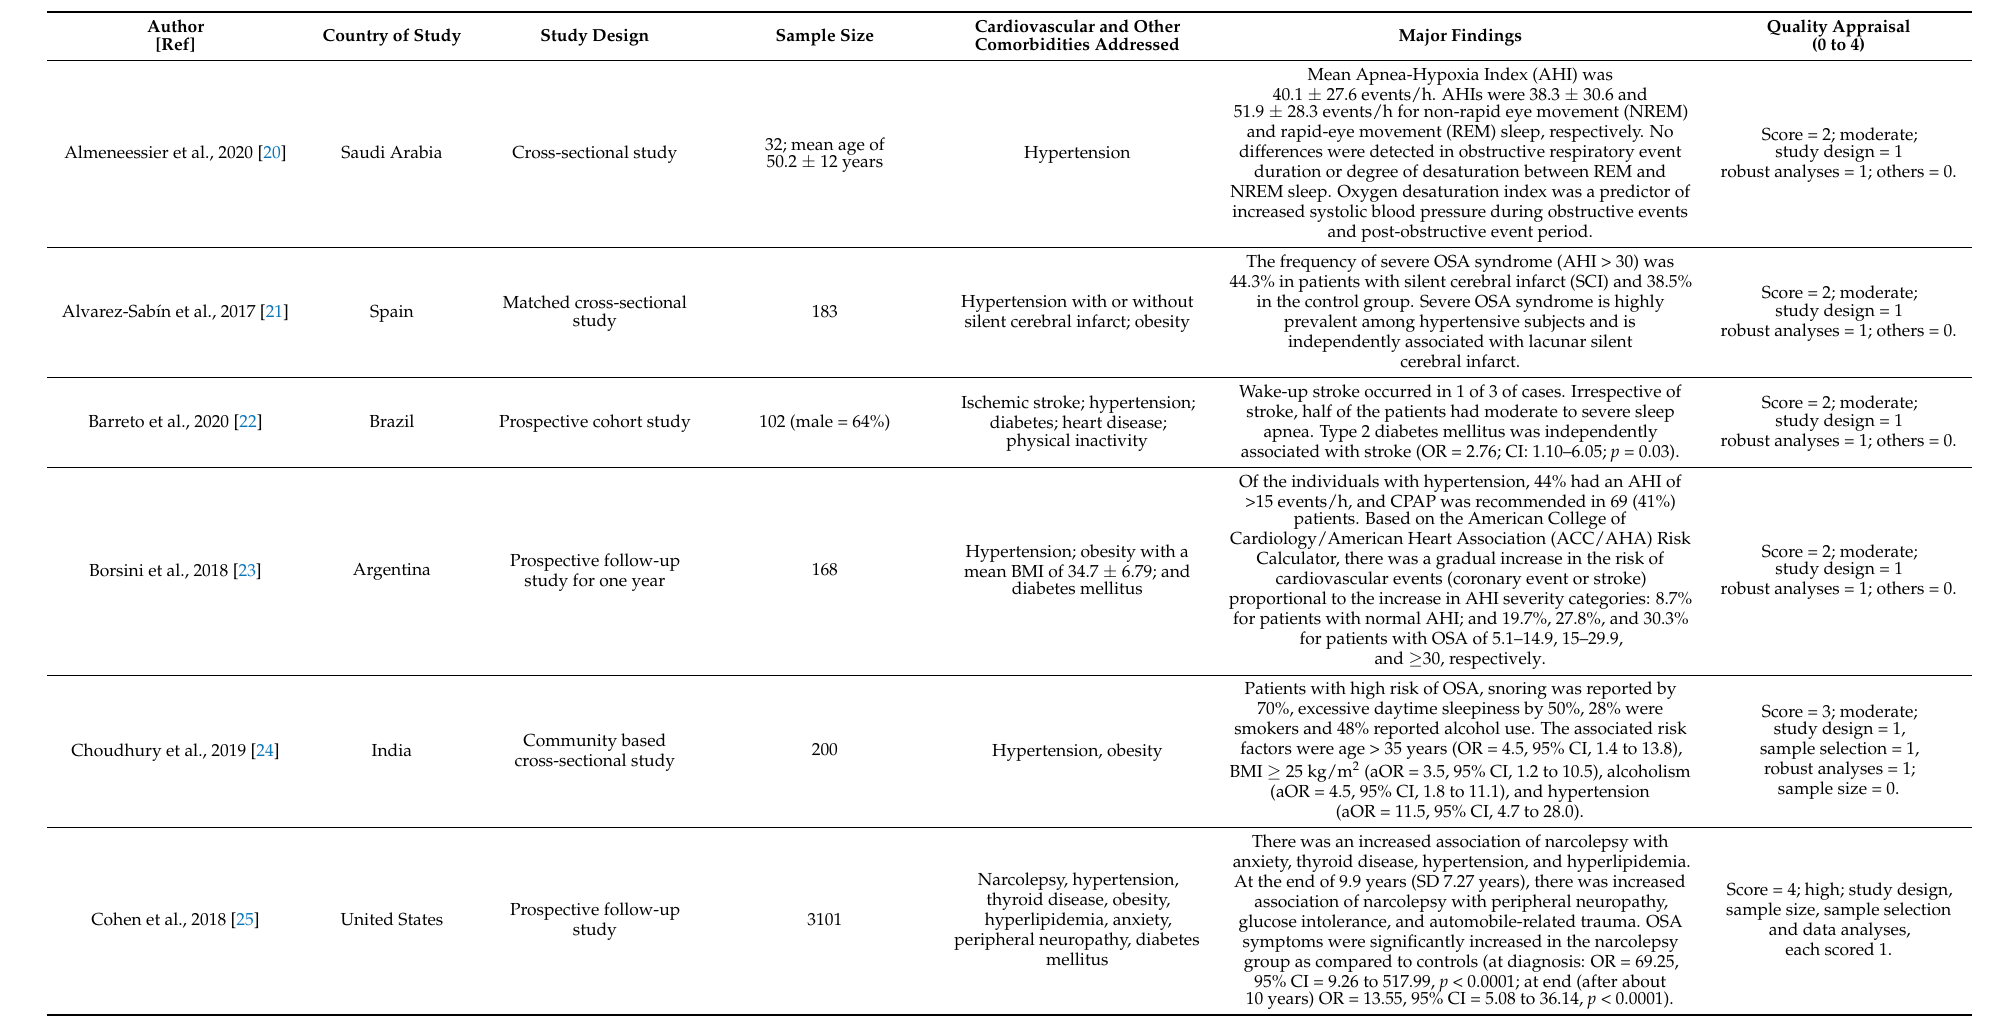
Table 2. Study design, diseases addressed, major findings, and the quality appraisal of the